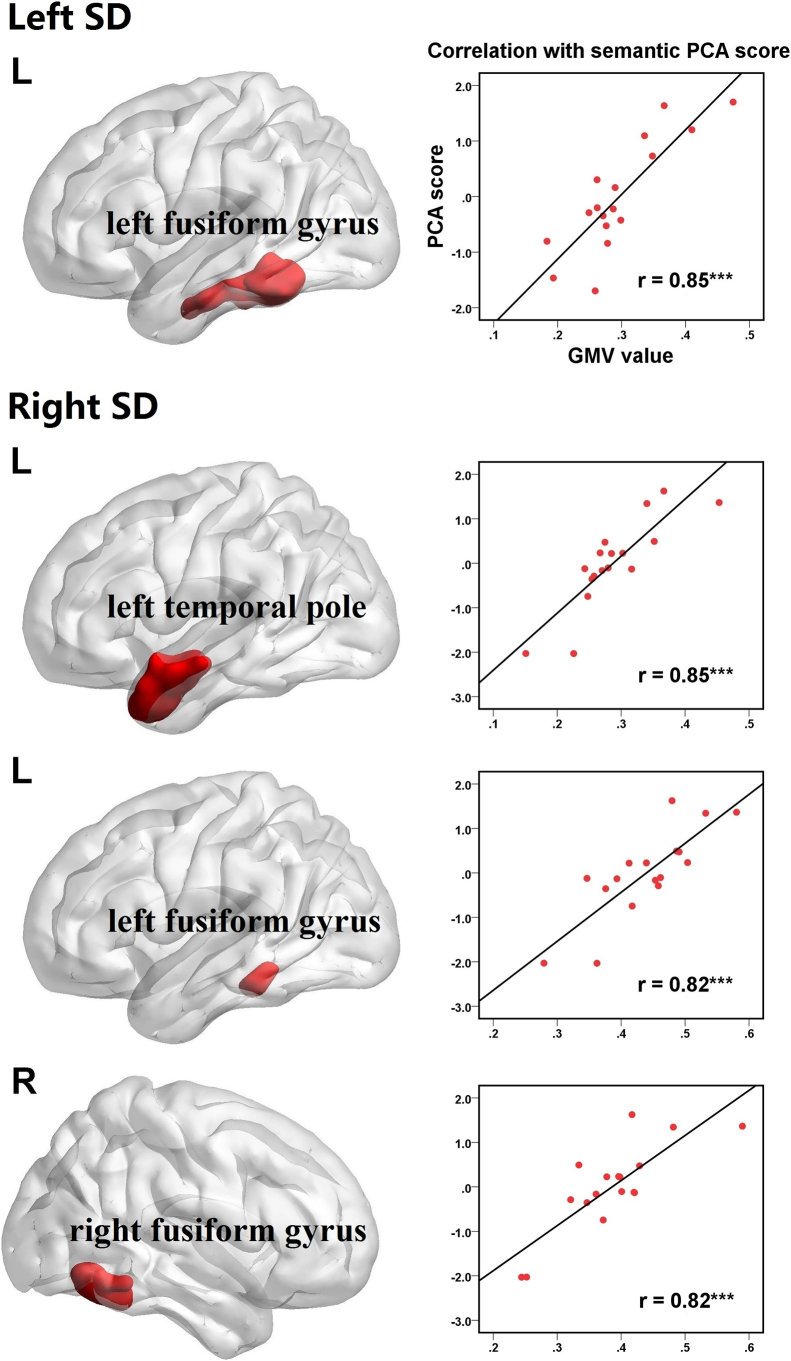
Relationship between GMV value of each SD-semantic related cluster and PCA score (GRF corrected, voxel p < 0.001 and cluster p < 0.05).